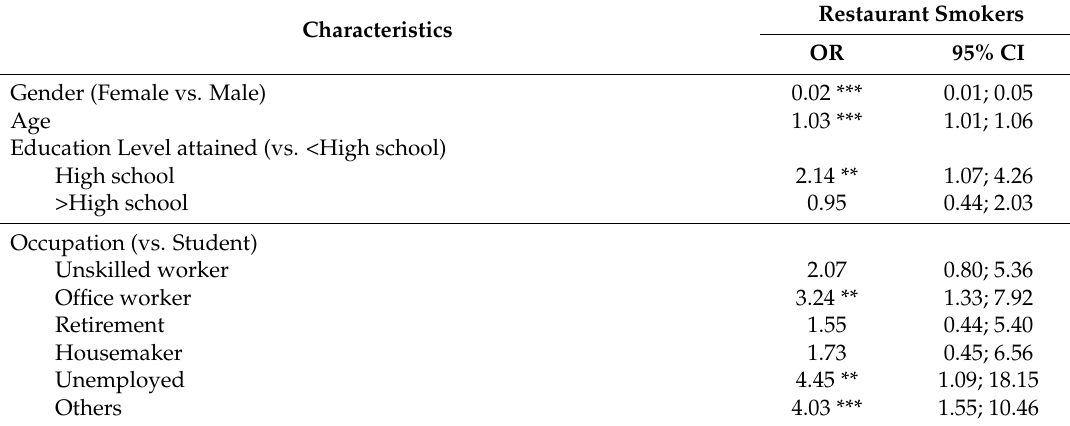
Table 4. Factors associated with smoking in the restaurant ( n =